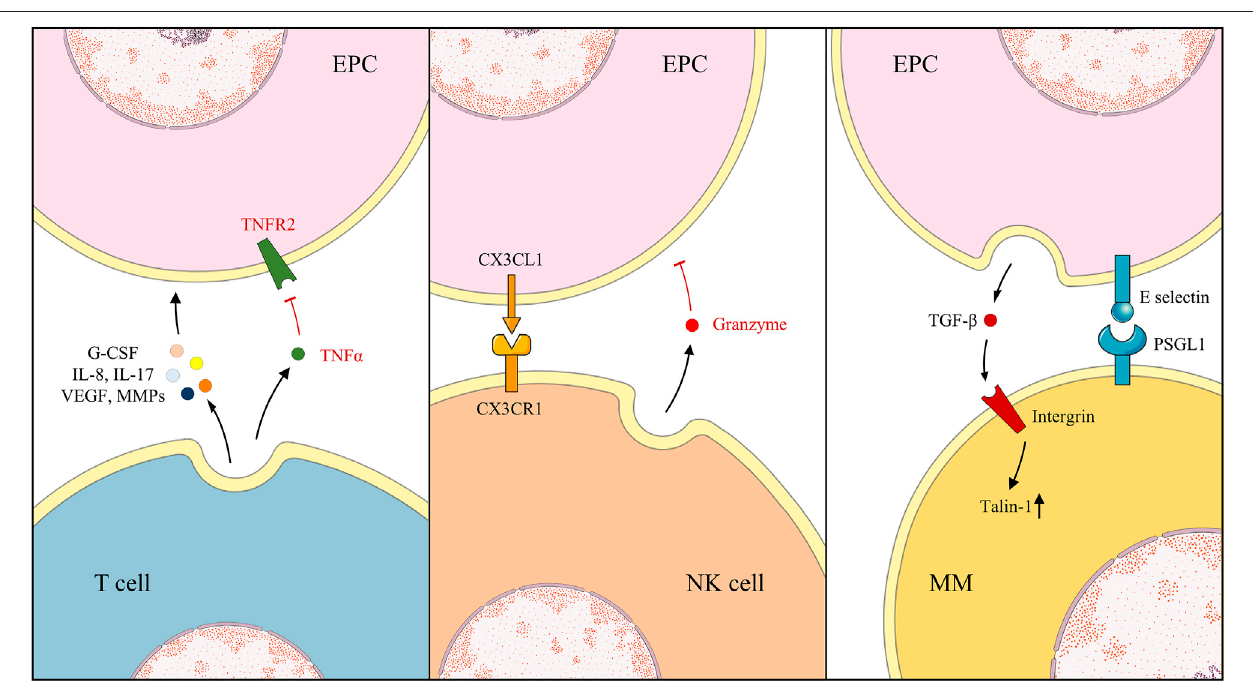
FIGURE 3 | Under different environments, EPCs, T cells, NK cells, and MMs exhibit various action and reaction modes.